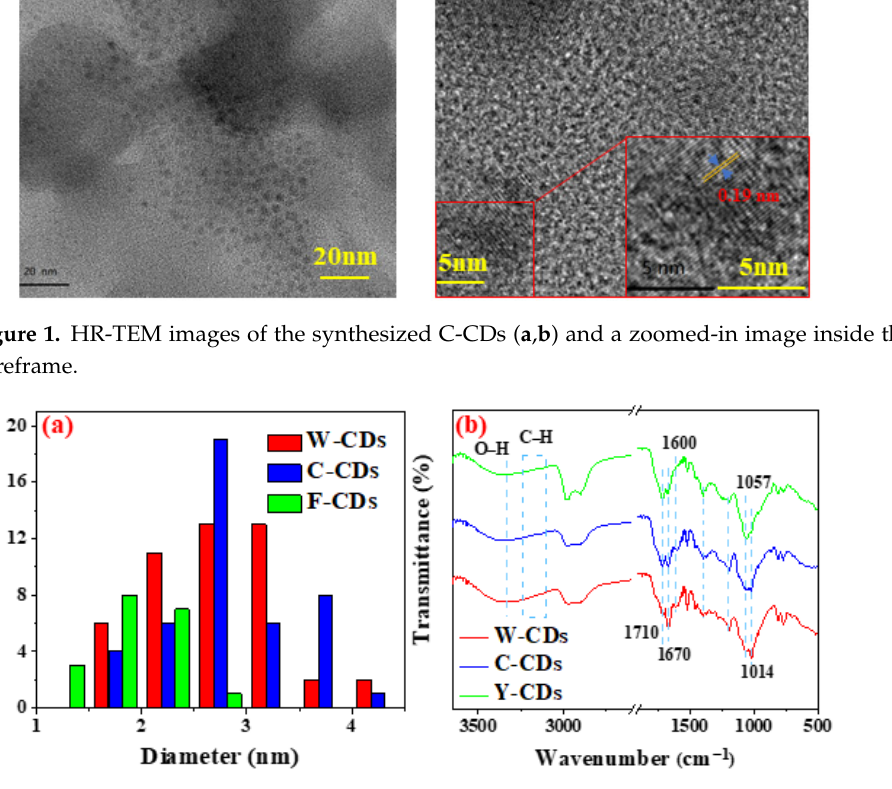
Figure 3. XPS full scan survey spectrum of the synthesized CDs and partially enlarged XPS spec- trum of N1s in upper right illustration ( a ); high-resolution XPS spectrum of C1s for W-CDs ( b ), C- CDs ( c ), and Y-CDs ( d ). Another distinction was shown in the enlarged picture of N1s (Figure 3a), in which the peak of N1s at 399 eV only existed in the Y-CD spectrum, excluding the W-CDs and